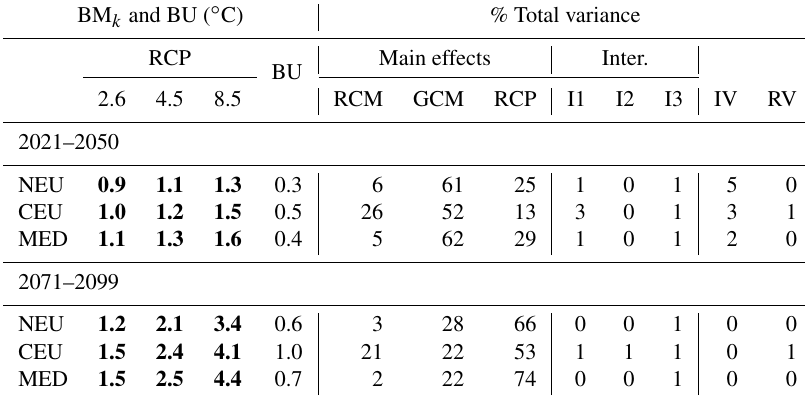
Table 4. Same as Table 2 for absolute changes in mean temperature in summer (JJA).